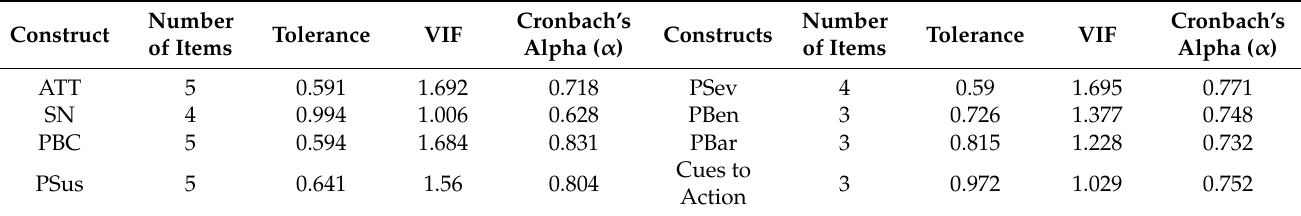
Table 1. Statistics of Construct